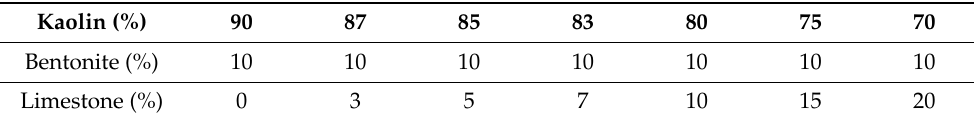
Table 1. Composition of the various